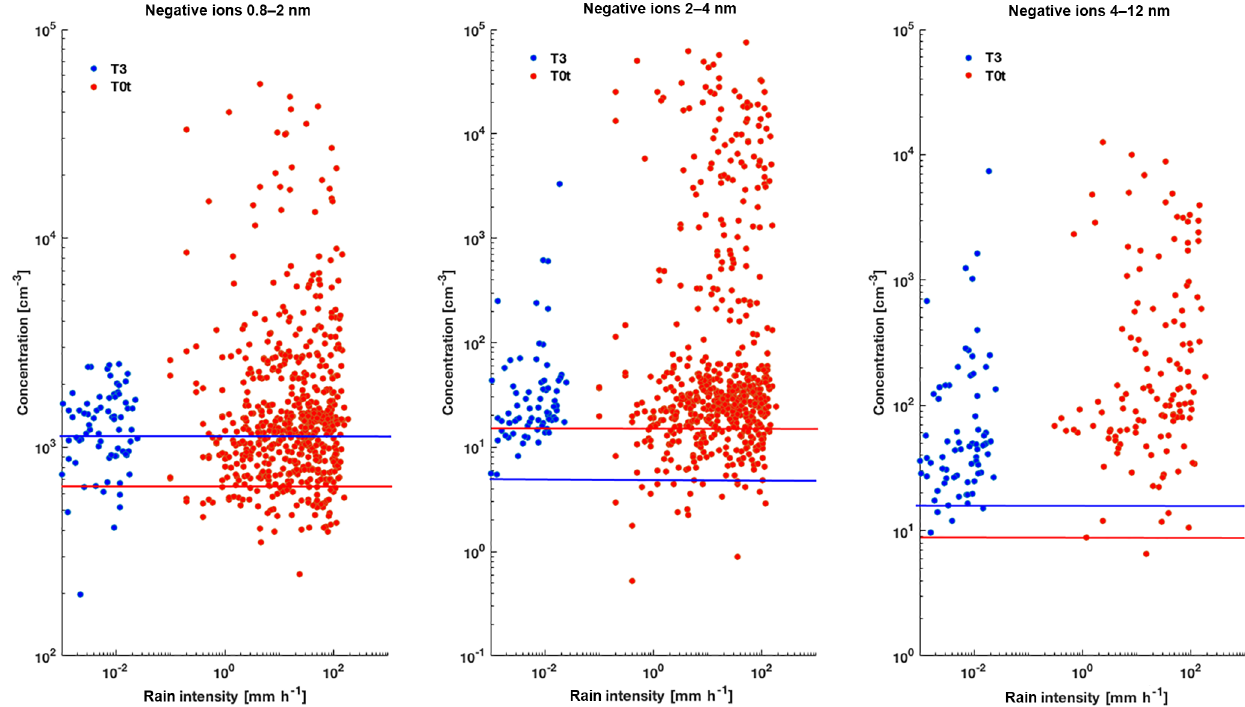
Figure 7. The maximum (99th percentile) negative ion concentrations as a function of rain intensity at the site inside the rainforest (T0t) between September 2011 and January 2014 (red circles) are shown. For comparison, the ion concentrations from the open pasture site are added (blue circles). The lines indicate the median ion concentrations in the absence of precipitation for T0t (red) and T3